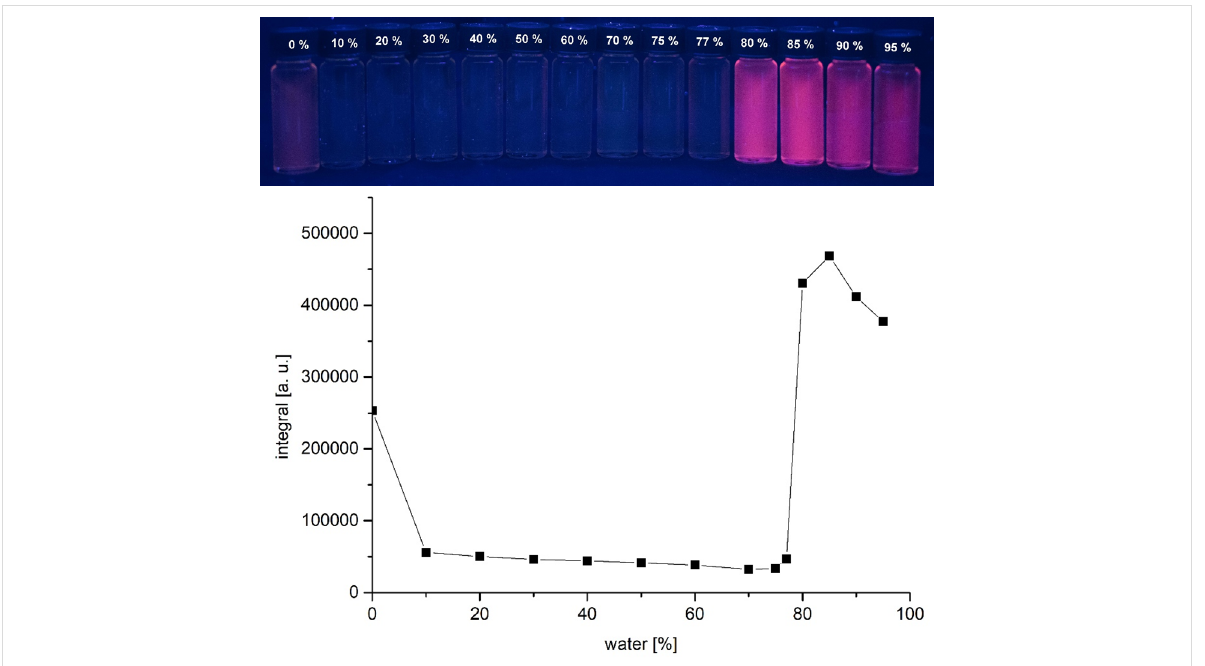
Figure 15: Fluorescence of compound 6e in different THF/water fractions (top, λ exc = 365 nm, handheld UV lamp) and I / I 0 vs %H 2 O of α -pyrone 6e in THF/water mixtures containing different water fractions (bottom, recorded at T = 298 K).